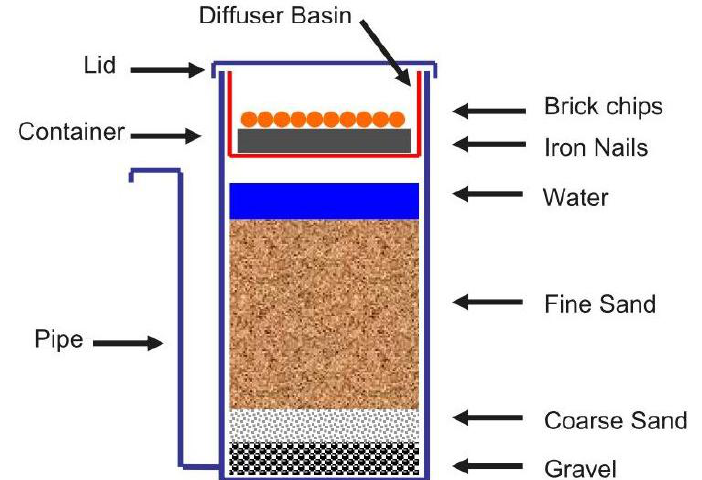
Figure 8. Cross-section through an arsenic Biosand filter which is similar to Kachan arsenic filter (Source: CAWST, 2009)